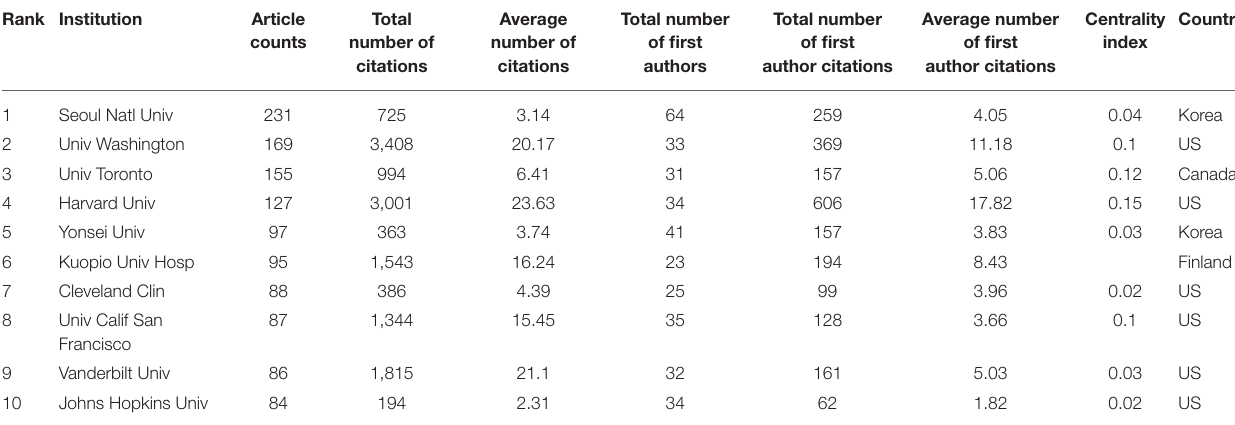
TABLE 2 | The top 10 institutions for most publications in spinal stenosis research.